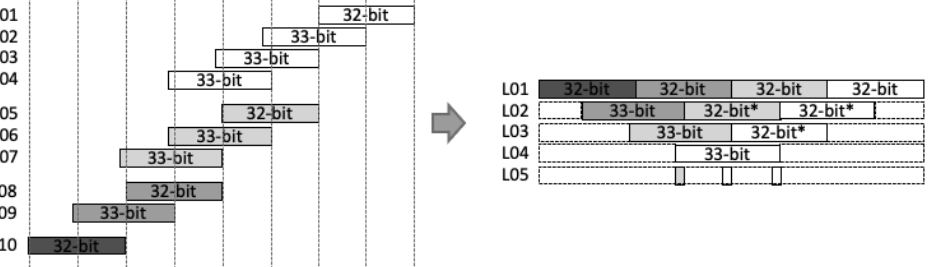
Figure 3. Example of alignment for intermediate values in a 64-bit multiplier.